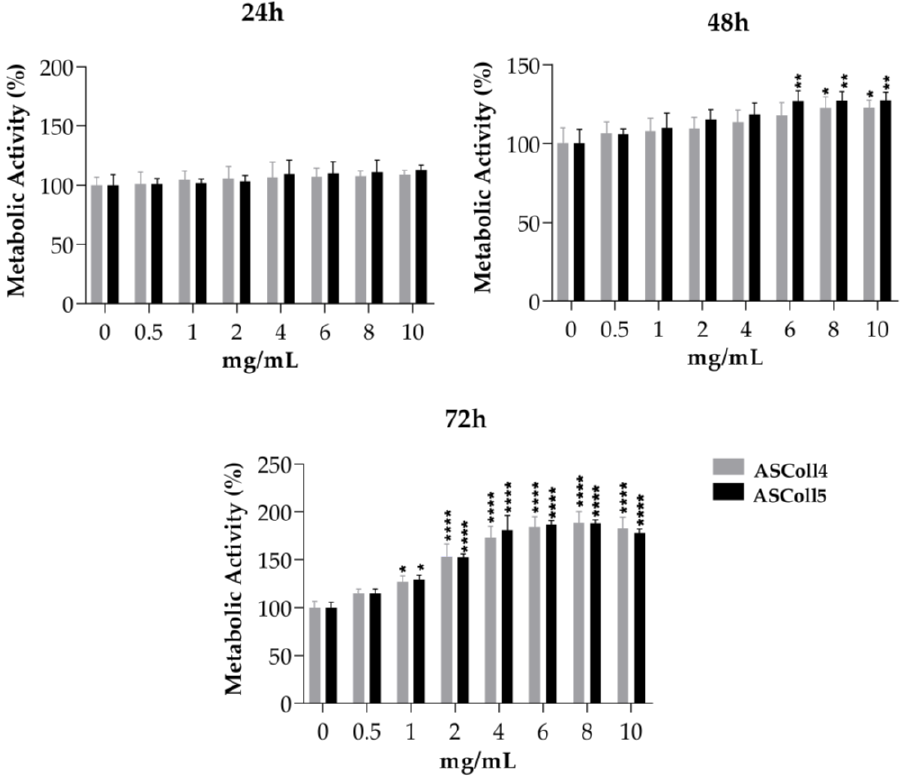
Figure 5. Cell viability of HaCaT keratinocytes after being cultured with different concentrations of ASColl from two different extractions (4th and 5th extraction), as measured by MTS assay. The pre- sented values are mean ± SD of at least three independent experiments and the data was considered statistically different if p < 0.05, when compared with the negative control (ASColl = 0 mg/mL) by two-way ANOVA, followed by Tukey’s test. * p < 0.05; ** p < 0.01; **** p < 0.0001.